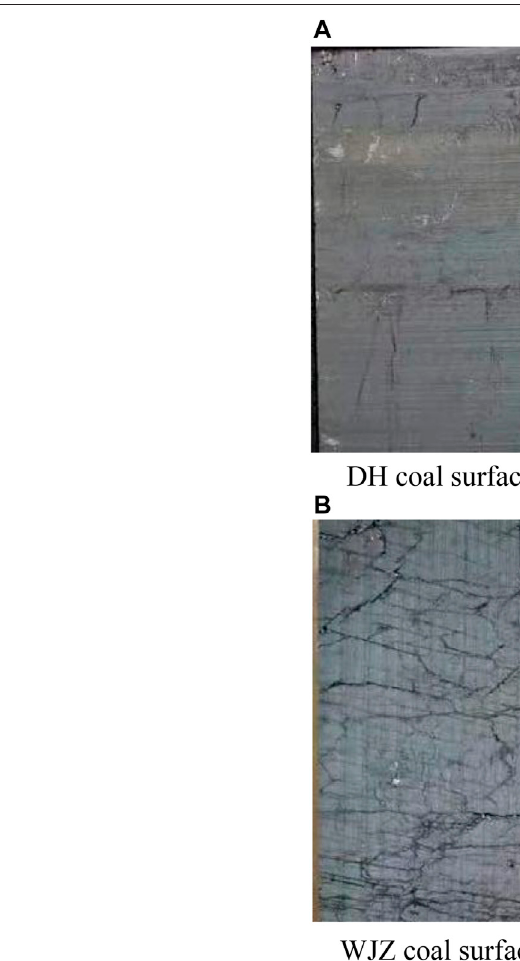
FIGURE 10 | Primary fractures and binarization of WJZ coal (size 50 mm × 75 mm). (A) DH coal surface crack and binarization picture (B) WJZ coal surface crack and binarization picture.